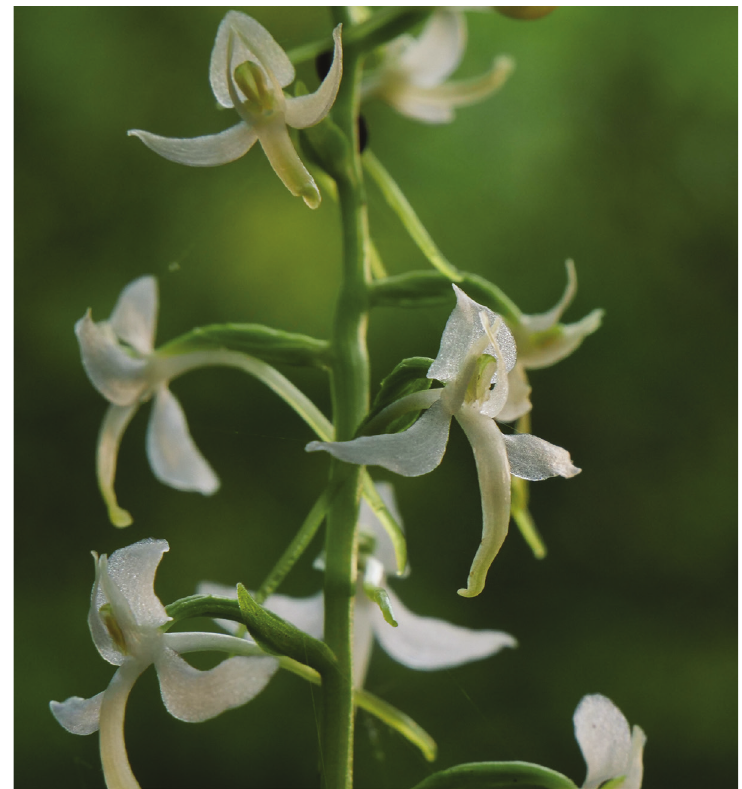
Figure 5. Inflorescence of Platanthera kuenkelei H.Baumann subsp. kuenkelei . Photograph by V. Rodi.